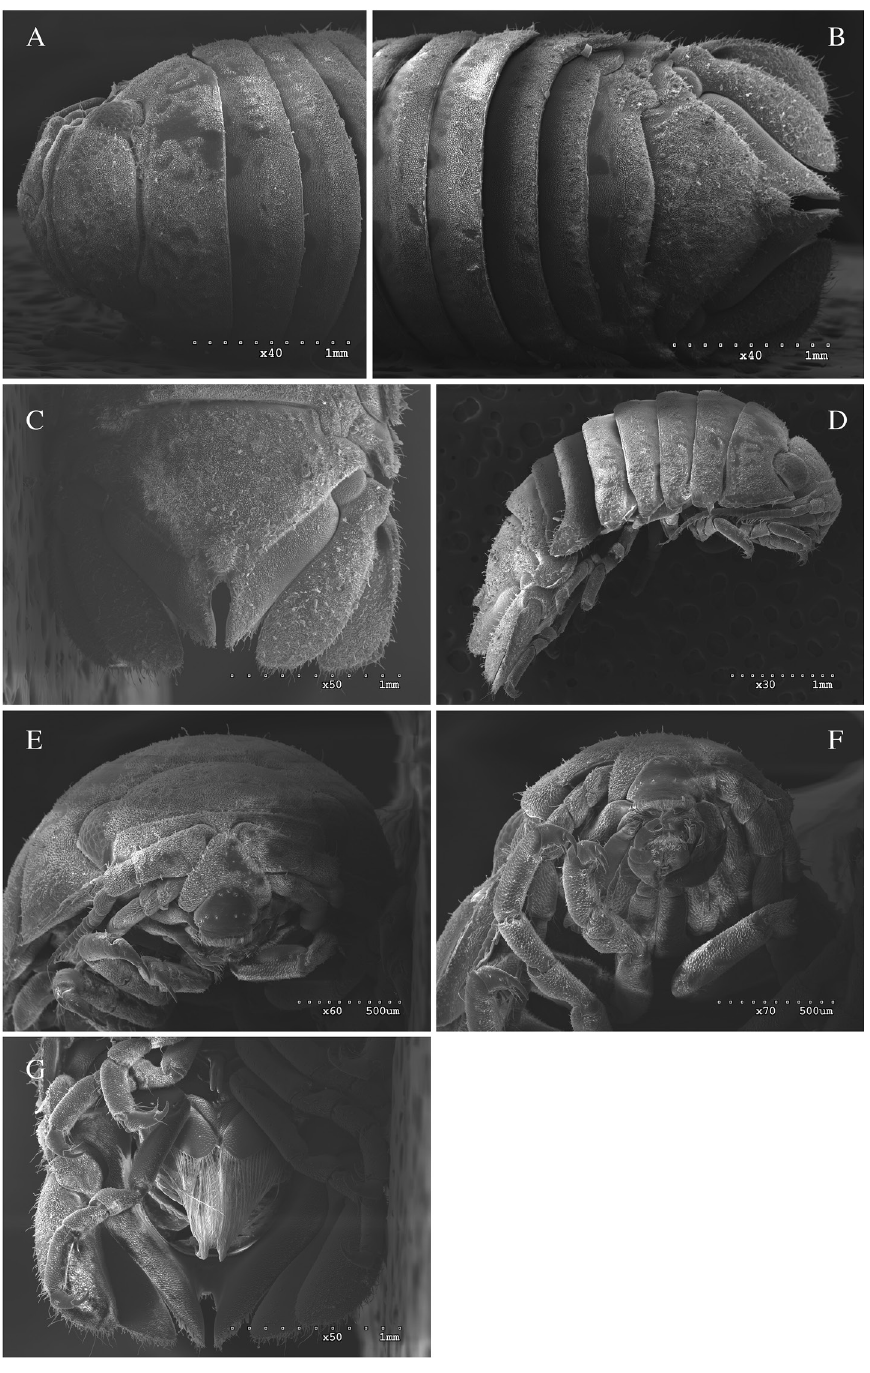
Figure 5. Dynoides elegans . ♂ , non-type. LACM-MBPC 17829. A anterior dorsal B posterior dorsal C pleotelson D lateral E clypeus, labrum F mouthfield G ventral with